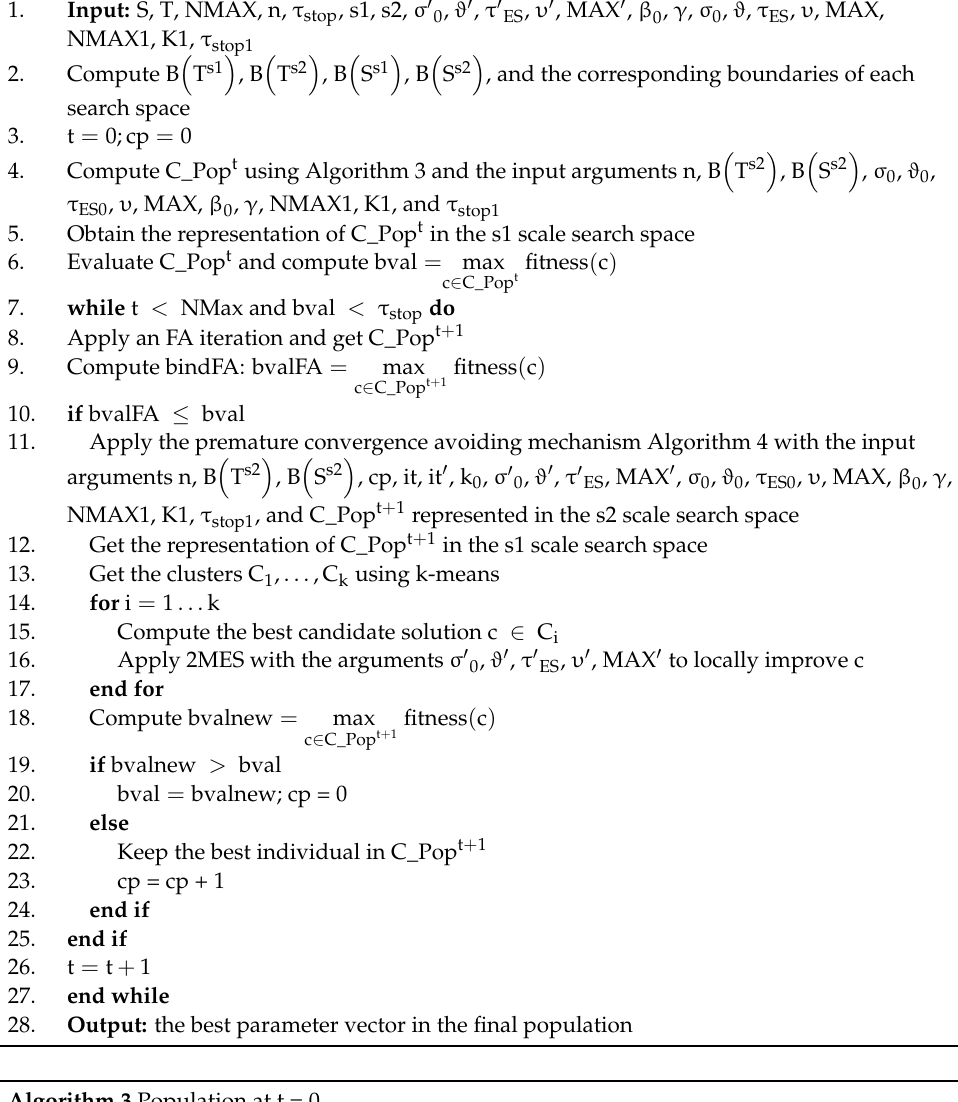
Algorithm 2 Multi-Scale Memetic Algorithm